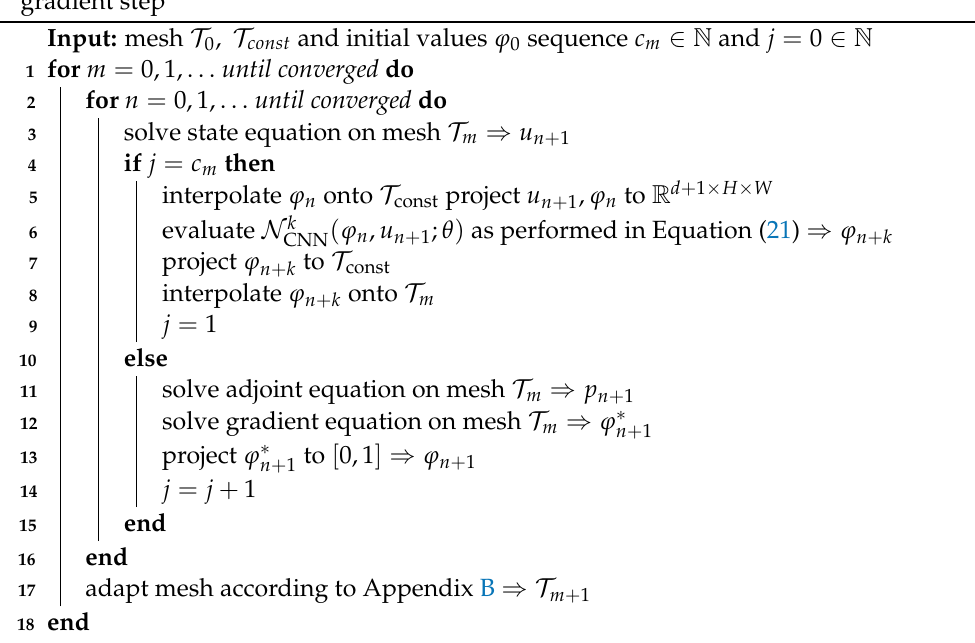
Algorithm 1: Deterministic optimisation algorithm with TCNN approximated gradient